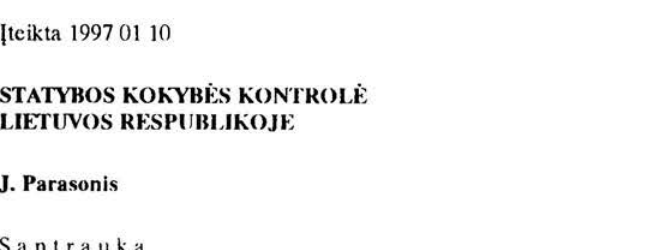
Developing this topic, it